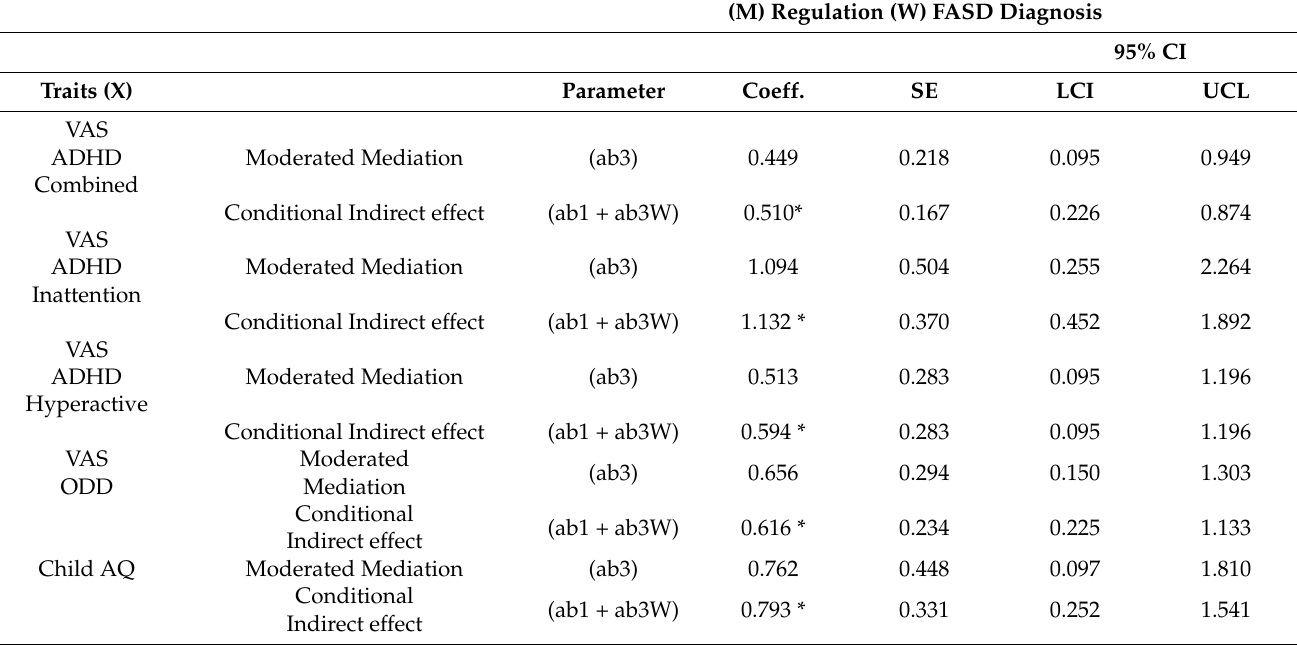
Table 5. Moderated mediation results for the moderated mediation models with Regulation as the